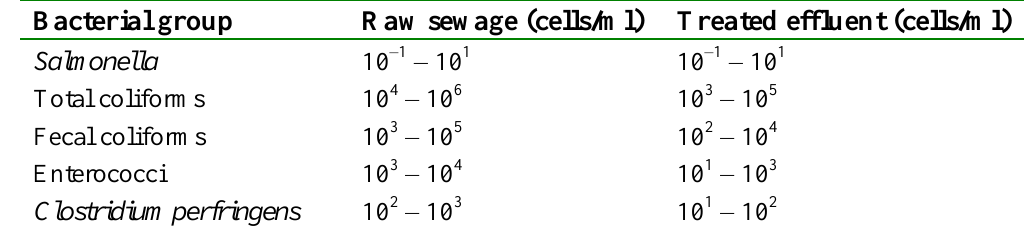
Table 8. Typical concentrations of selected bacteria in raw and treated domestic wastewater a